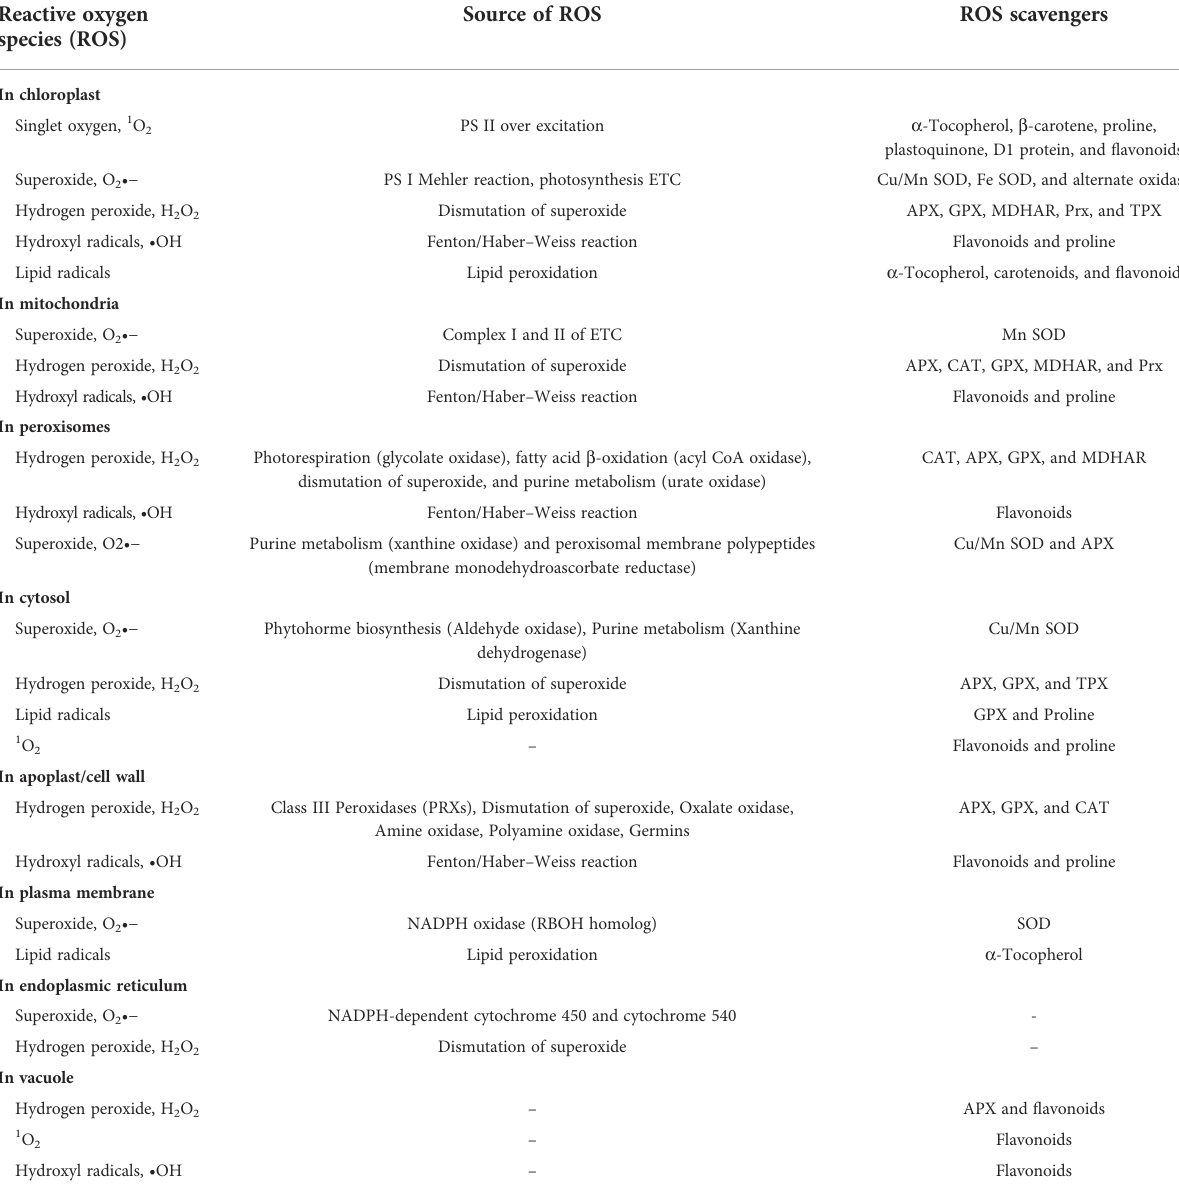
TABLE 1 Mechanism of ROS generation and detoxi fi cation in different cellular compartment of plant cell. Reactive oxygen species